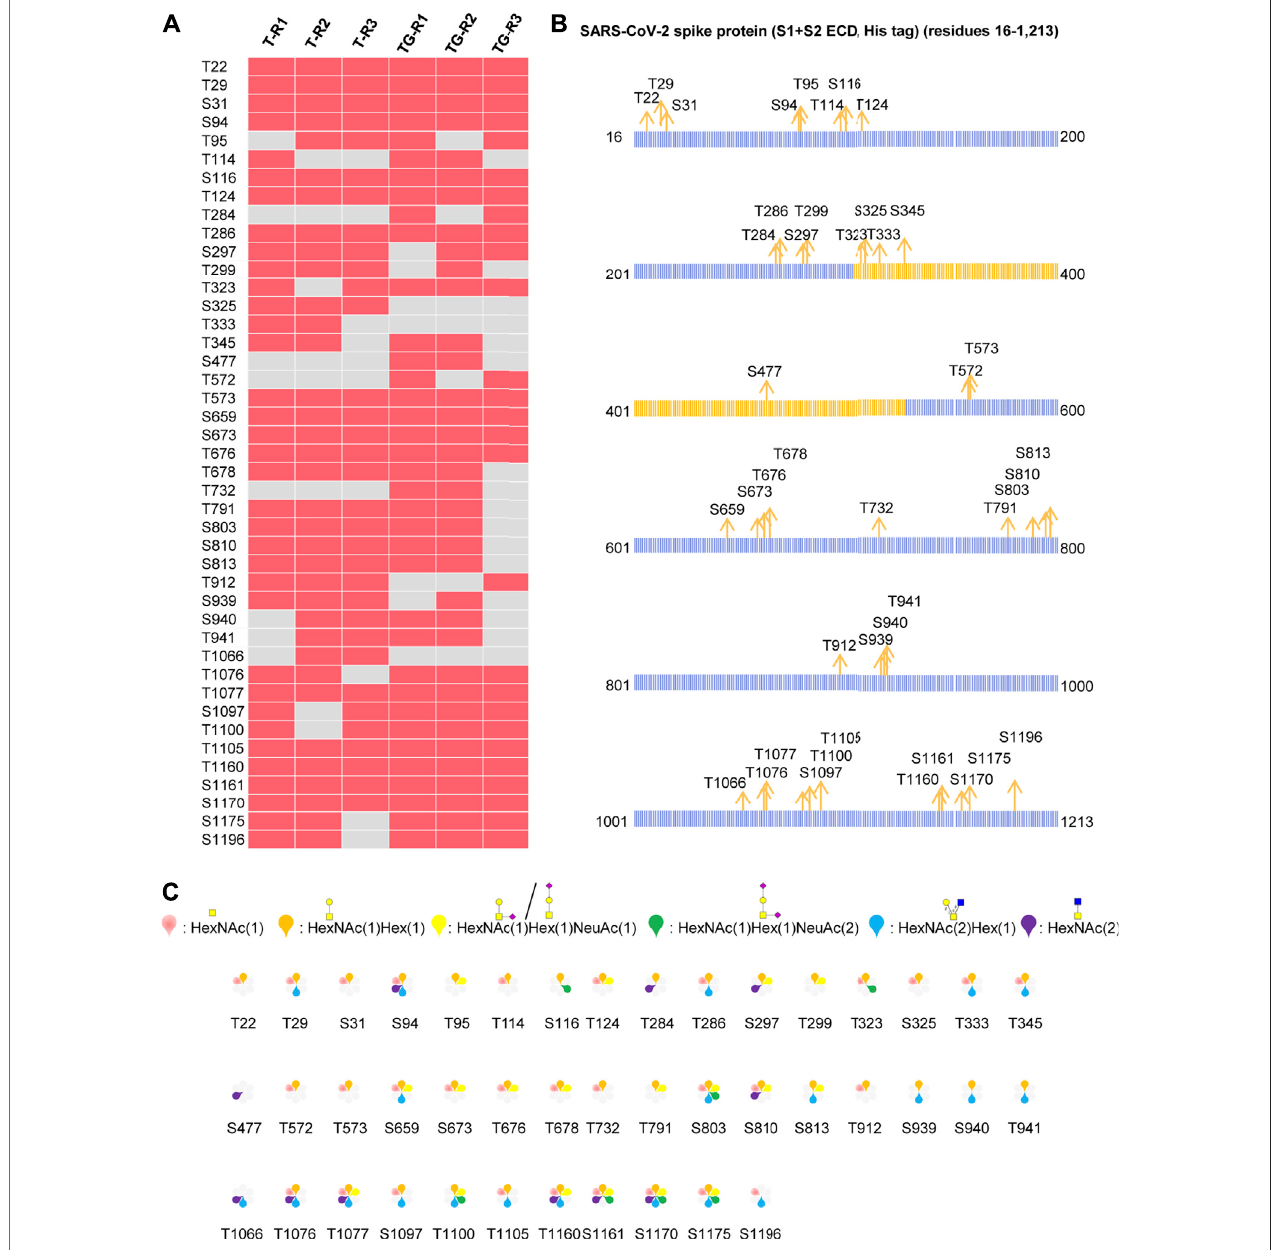
FIGURE2| Comprehensive O -glycosylation characterizationofrecombinantSARS-CoV-2Sprotein (S1+S2 ECD, Histag) expressed ininsect cells. (A) Uncertain O -glycosites identi fi ed using trypsin (T) or typsin/Glu-C (TG) in three replicates. (B) Mapping of identi fi ed O -glycosites to amino acid sequences. RBD is highlighted in yellow. (C) O -glycan compositions on each